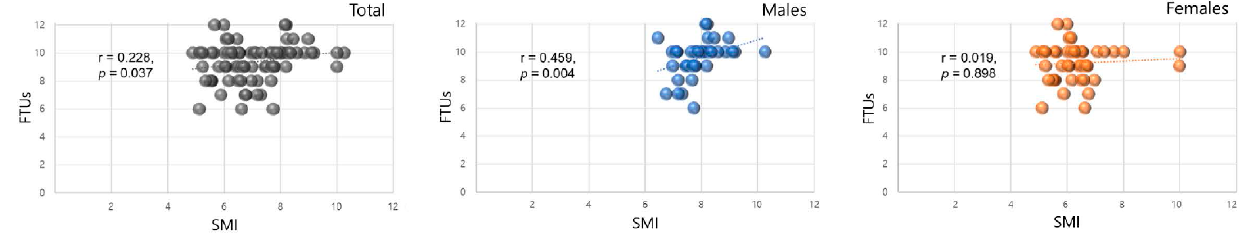
Figure 4. Correlation between the skeletal mass index (SMI) and functional tooth units (FTUs). Table 2. Mixing ability index-related variables.